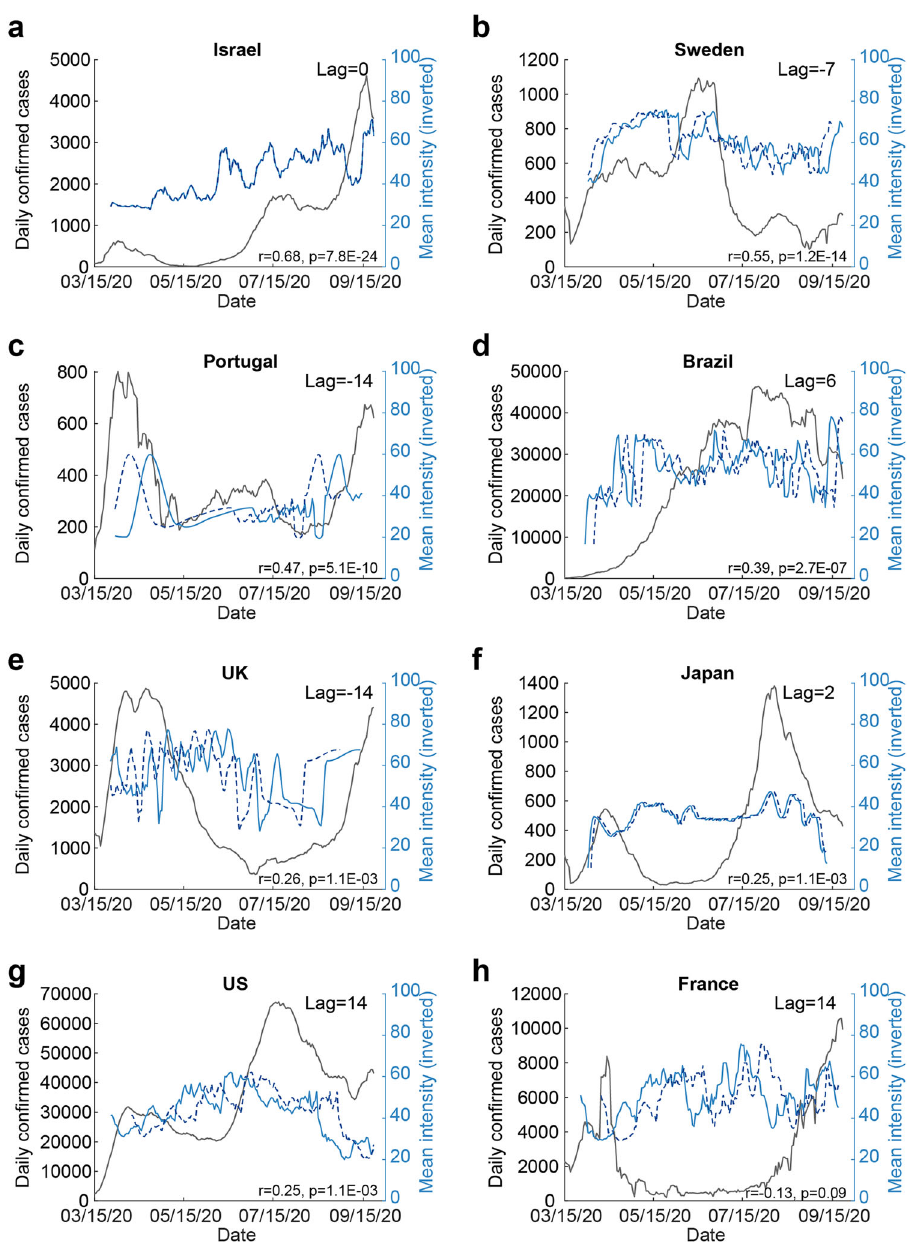
Fig. 3 Odorant intensity estimates correlated with national COVID-19 infection rates over time. a The correlation between intensity estimates and national levels of COVID-in Israel. Blue line: mean daily additive inverse intensity ratings. Dashed blue line: shifted additive inverse intensity time-series, after fi nding the peak lag using cross correlation (see “ Methods ” section). Black line: number of daily con fi rmed cases in each country. Note that when the lag is close to zero, then the dashed and solid blue lines align and overlap. All other panels the same as a but for: b Sweden. c Portugal. d Brazil. e United Kingdom. f Japan. g United States. h